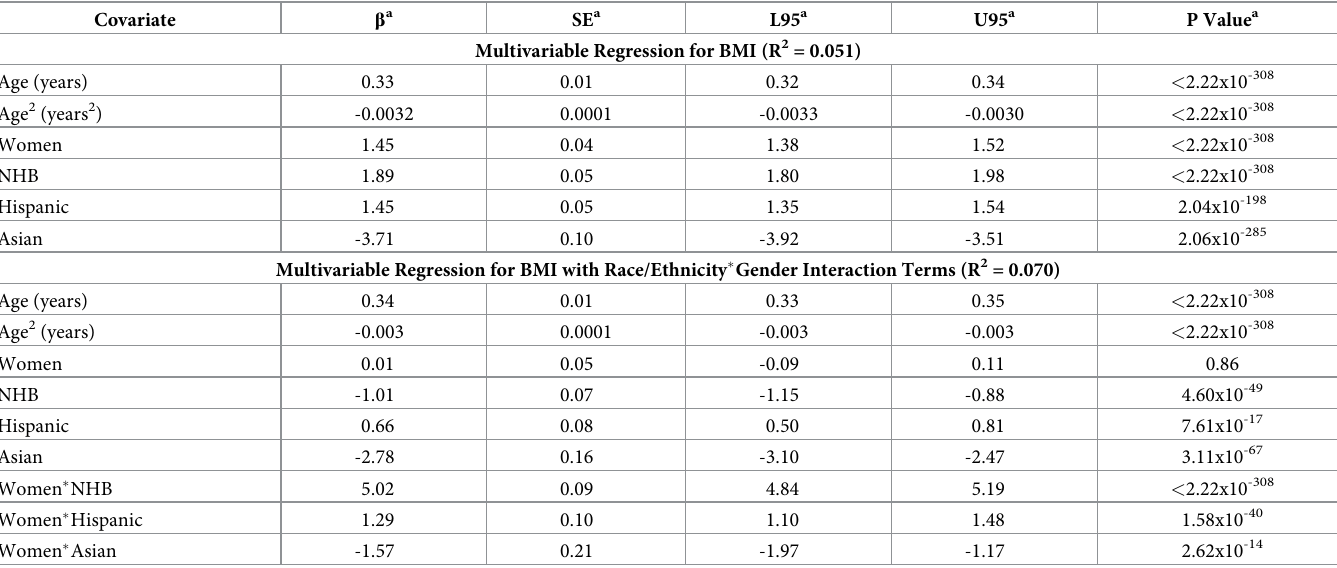
Table 2. Results of multivariable linear regression models for body mass index. Covariate β